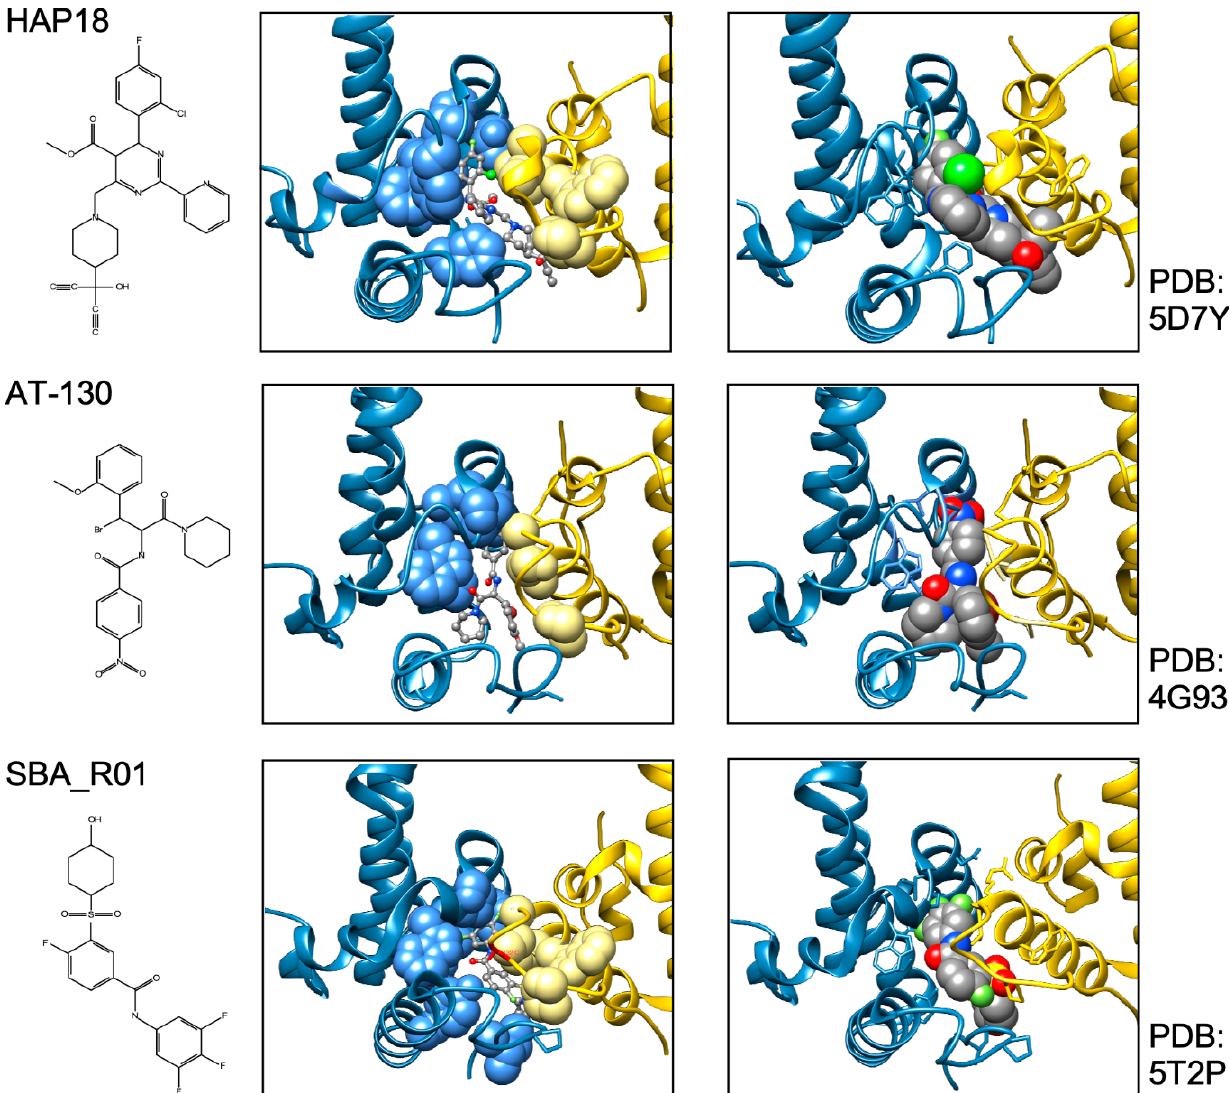
Figure 10. Different CAMs share a common binding pocket yet display non-identical binding modes. All currently known CAMs bind in the HAP pocket formed at the Cp inter-dimer interface with one Cp subunit (in blue) providing most contacts, and the second subunit (in gold) “capping” the bound compound. The compounds represent the classical chemotypes of HAP (HAP18), phenylpropenamide (AT-130) and sulfamoylbenzamidine (SBA_R01). Shown from left to right are the name and chemical formula of the respective CAM; a close-up of the HAP pocket with the most relevant protein residues as spheres and the CAM as ball-and-stick model; and the same view but some relevant protein residues as sticks and the CAM atoms as spheres. The corresponding PDB entries are given on the right. Note that despite their different chemical structure all three CAMs fit snuggly into the binding pocket yet engage both common and distinct Cp residues. This correlates with overlapping but non-identical resistance profiles and addresses different pressure points in the capsid shell which, via allostery, results in different overall responses.